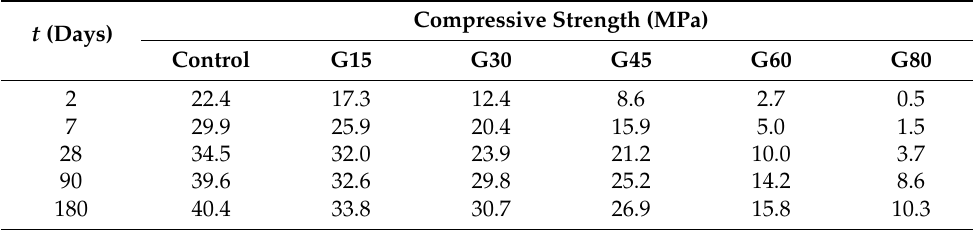
Table 4. Compressive strength of concrete manufactured with cement replaced by glass